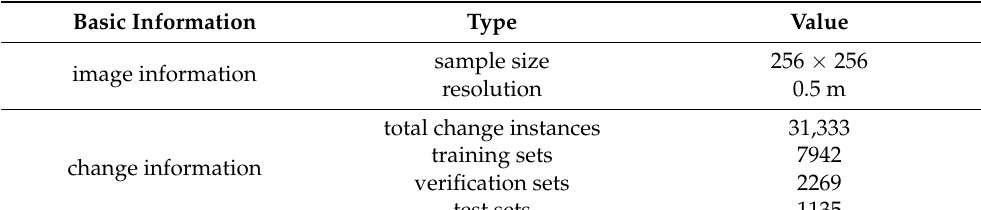
Table 2. LEVIR-CD building dataset basic information.